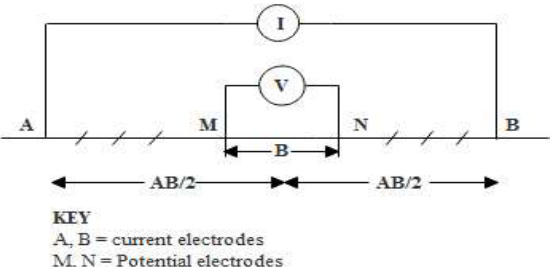
Figure 3. A schematic representation of VES layout using the Schlumberger electrode array, modified from [52].